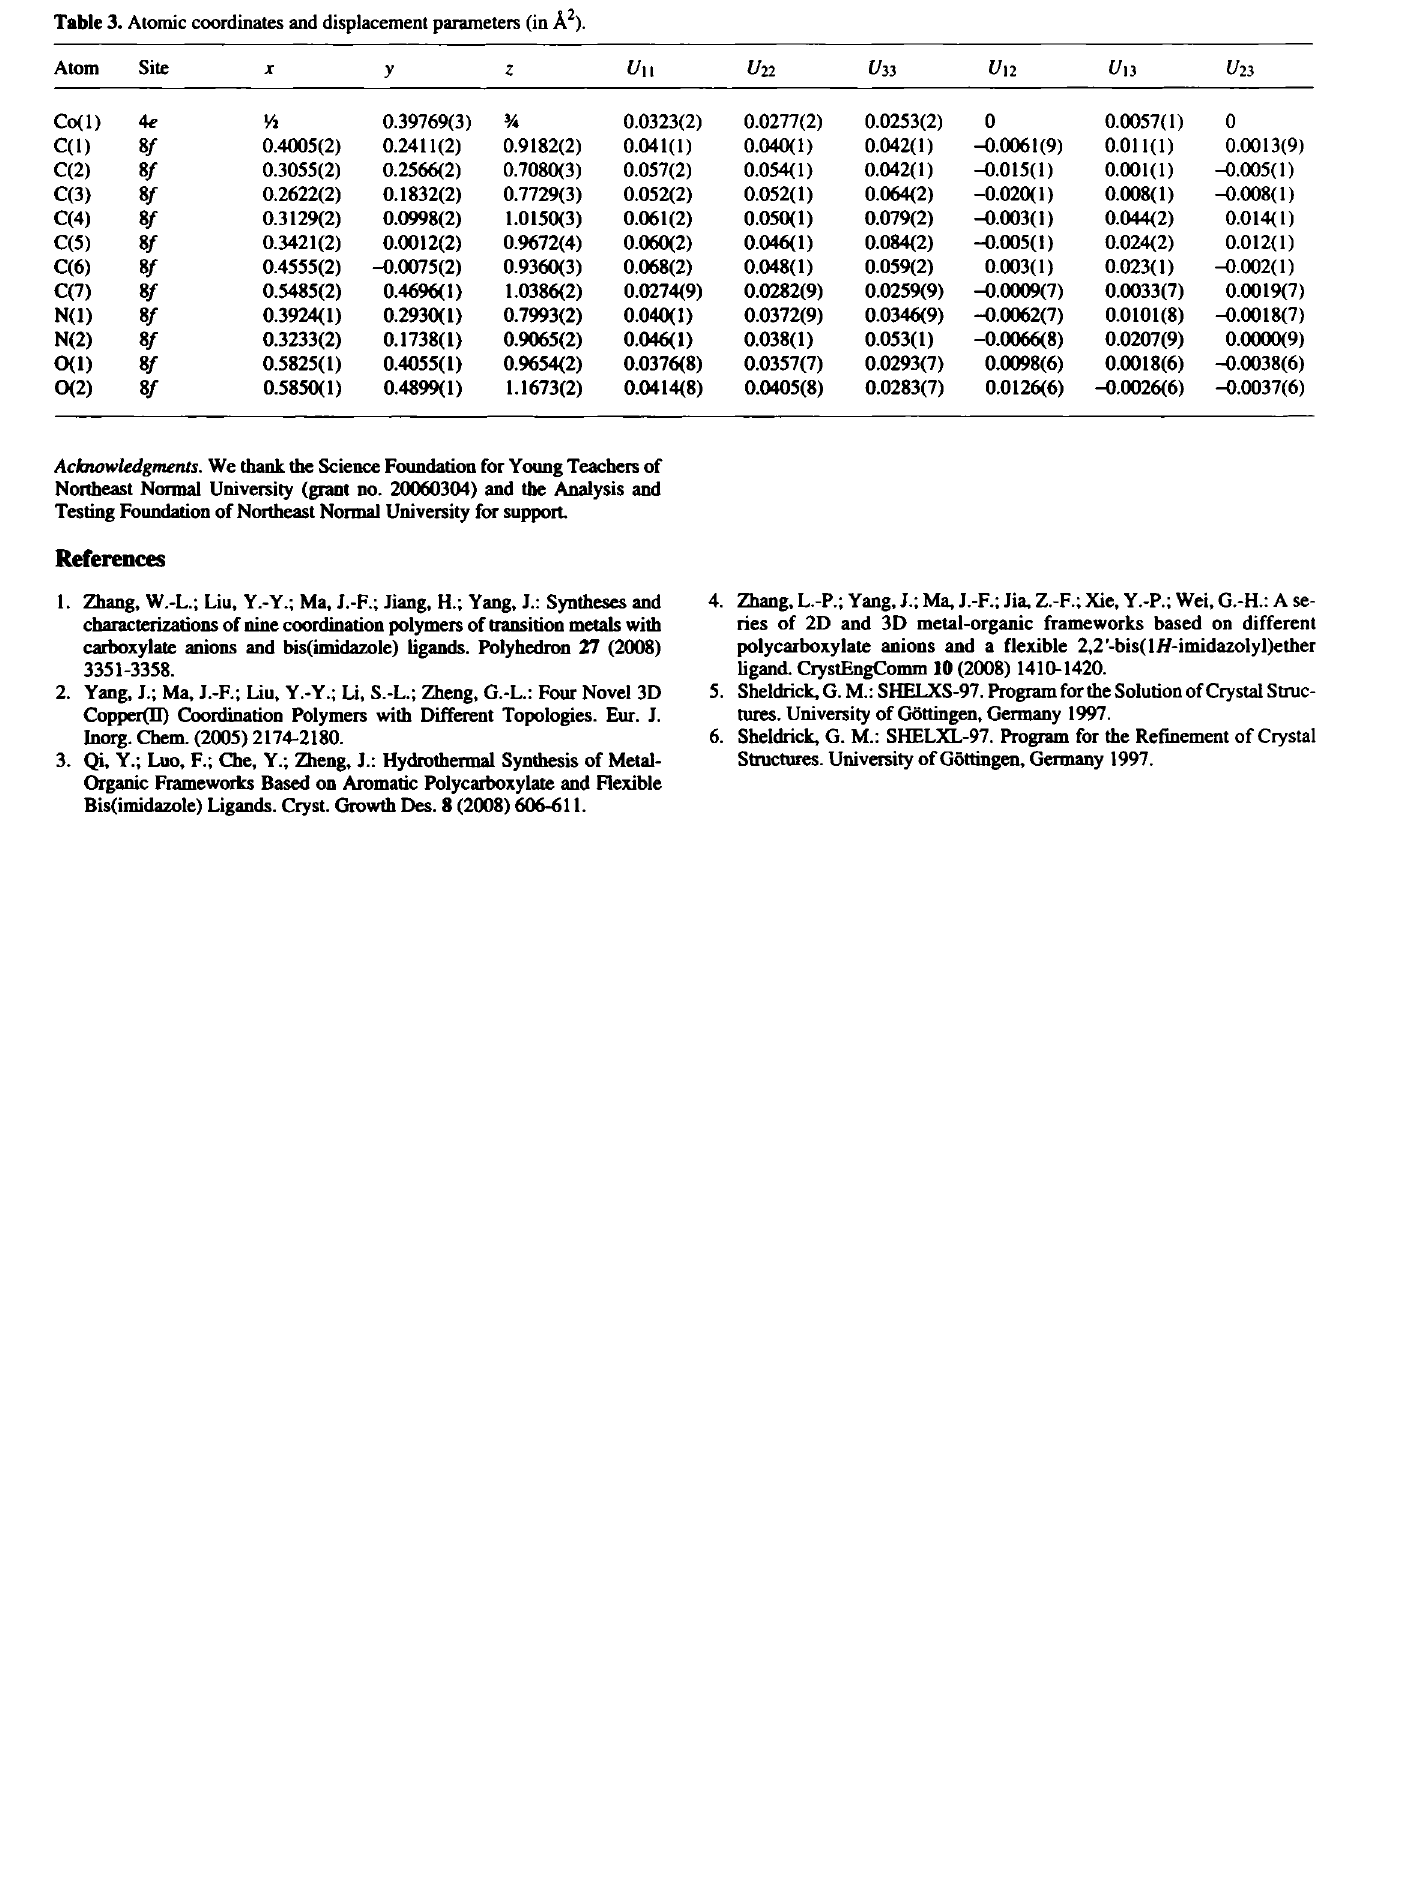
Table 3. Atomic coordinates and displacement parameters (in Â 2